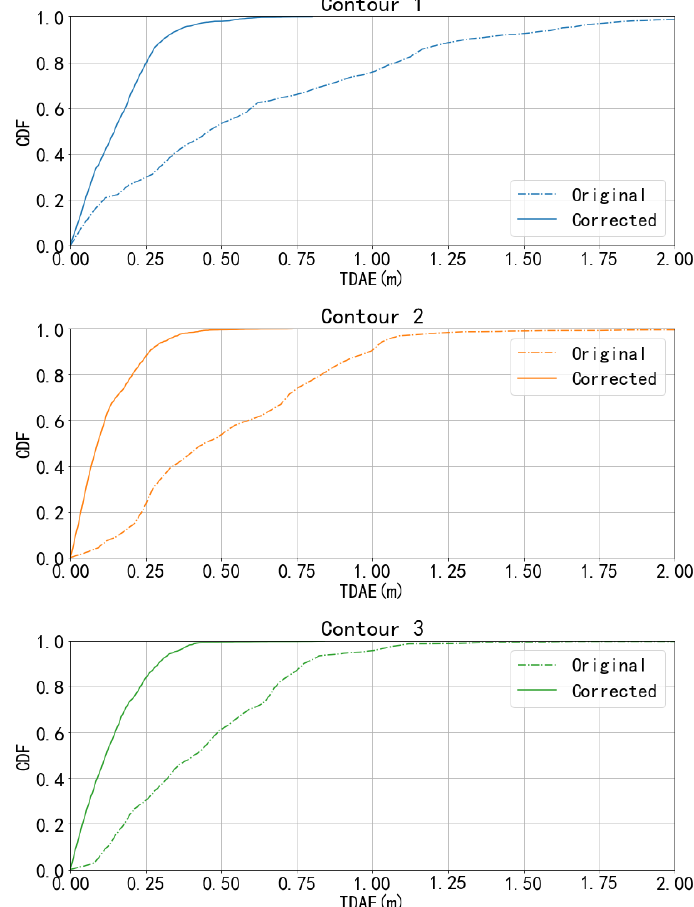
Figure 8. Comparison of the cumulative distribution function (CDF) between the original ranging results and the corrected results by our model in TDAE. The chain and solid lines represent the original ranging errors and corrected distance errors, respectively. Original refers to the error of the raw ToF distances in the dataset, denoted as d in Figure 3, and Corrected refers to the errors of the respective corrected distances calculated by DCNN, denoted as d t in Figure